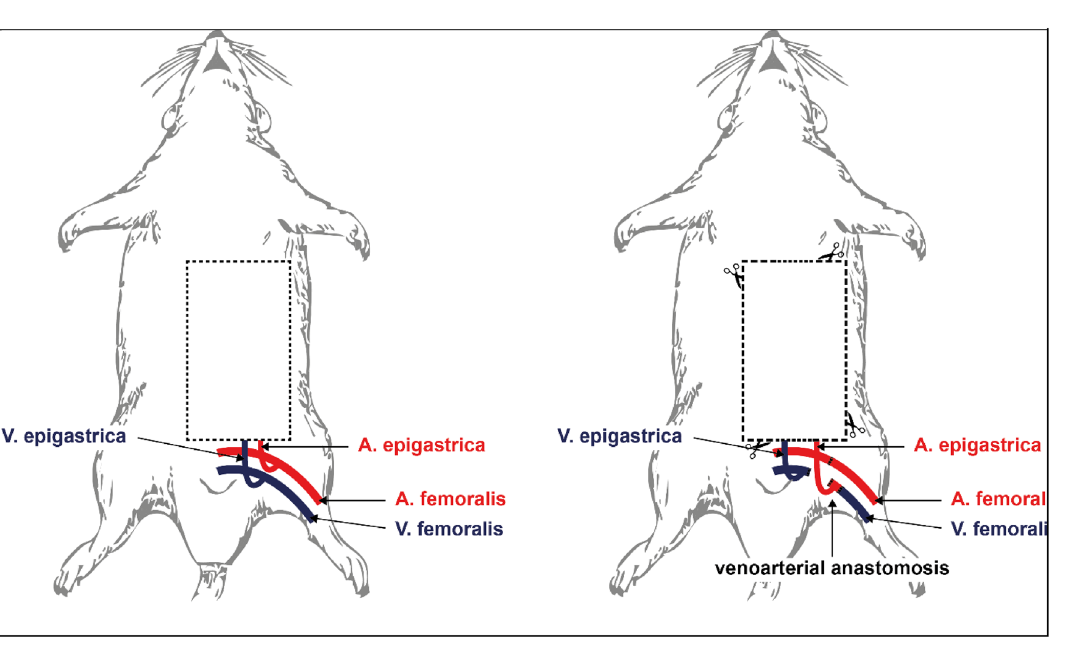
Figure 1. Schematic illustration of the experimental model. The femoral vein was ligated distal to the epigastric vein and the femoral artery proximal to the epigastric artery. The epigastric artery together with a distal part of the femoral artery was anastomosed with the distal femoral vein. An anastomosis of the proximal and distal part of the femoral artery was also